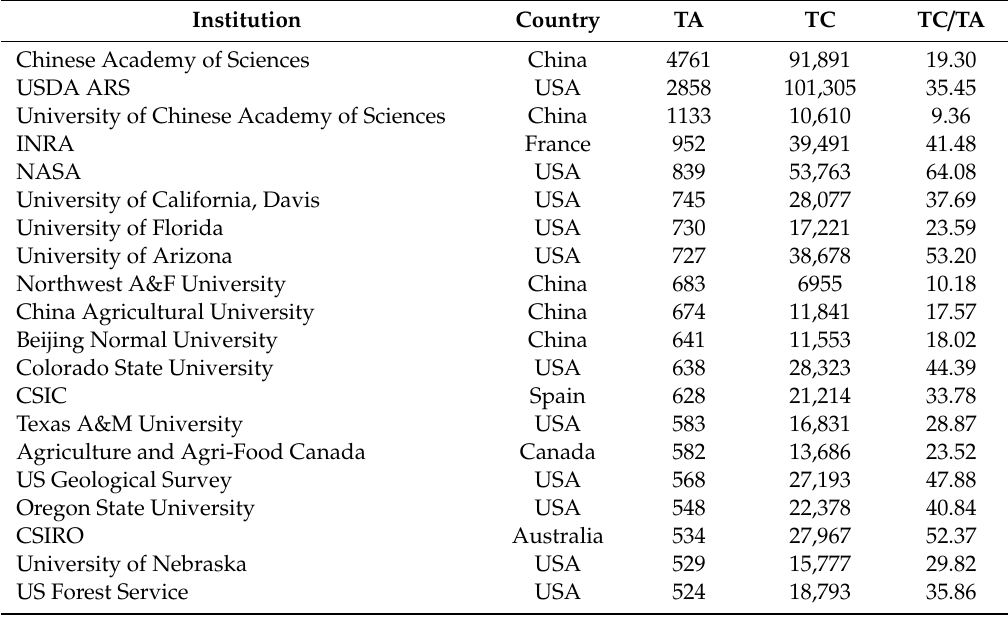
Table 3. Top 20 productive institutions in SW research during